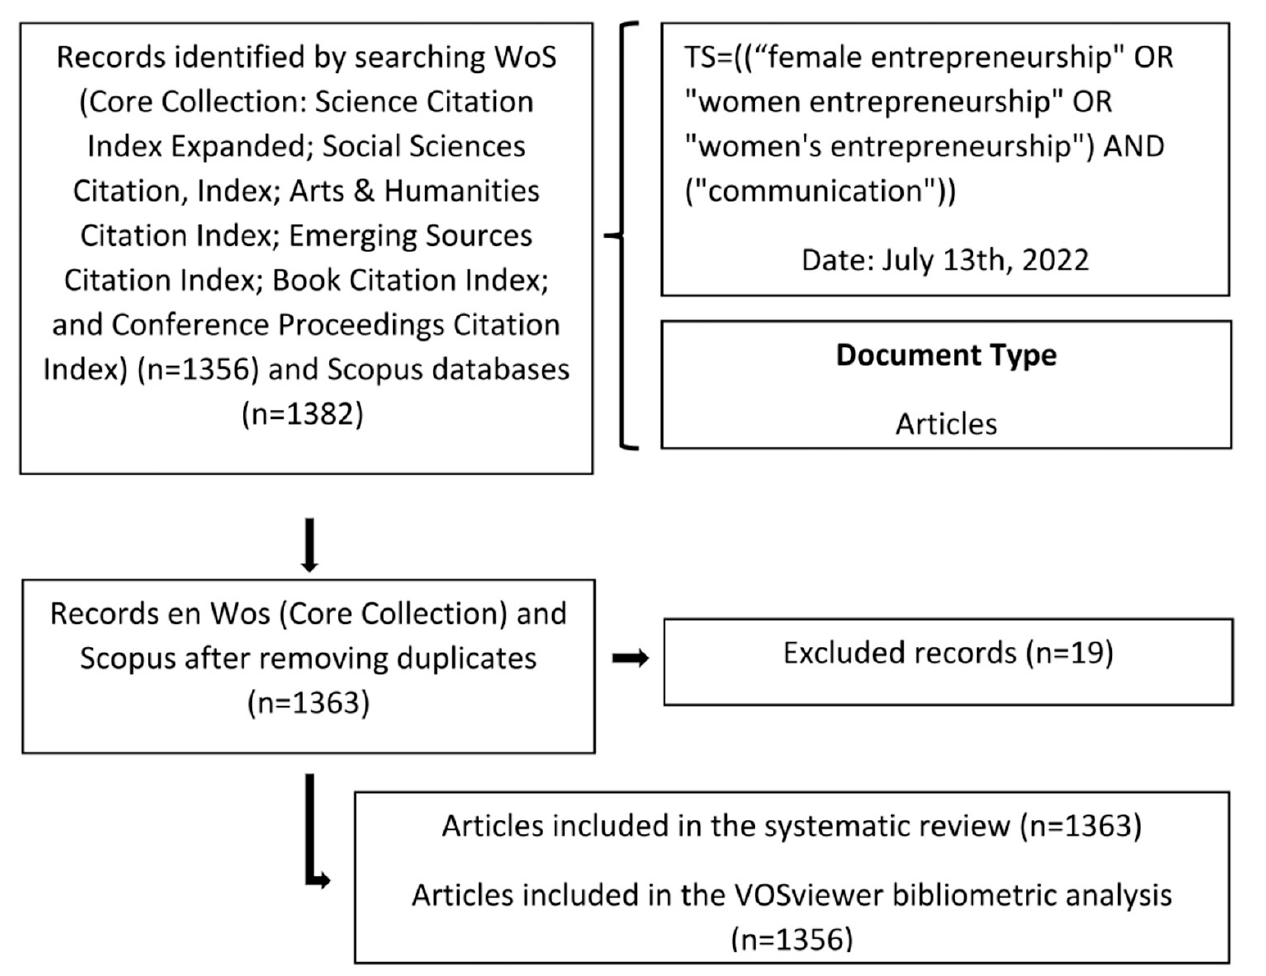
Figure 1. Flowchart of the bibliographic search and selection process.